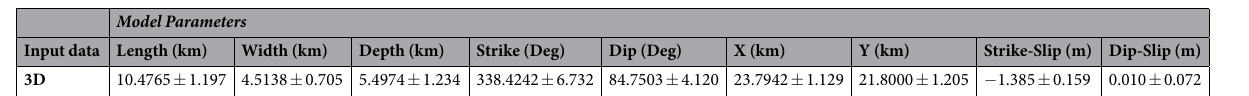
Table 2. Best-fit dislocation model parameters estimated from 3D displacement maps. * One-sigma uncertainties with optimum model parameters. ** The ground coordinates at the origins of the X and Y axes are − 122.545833 and 38.460556 deg,